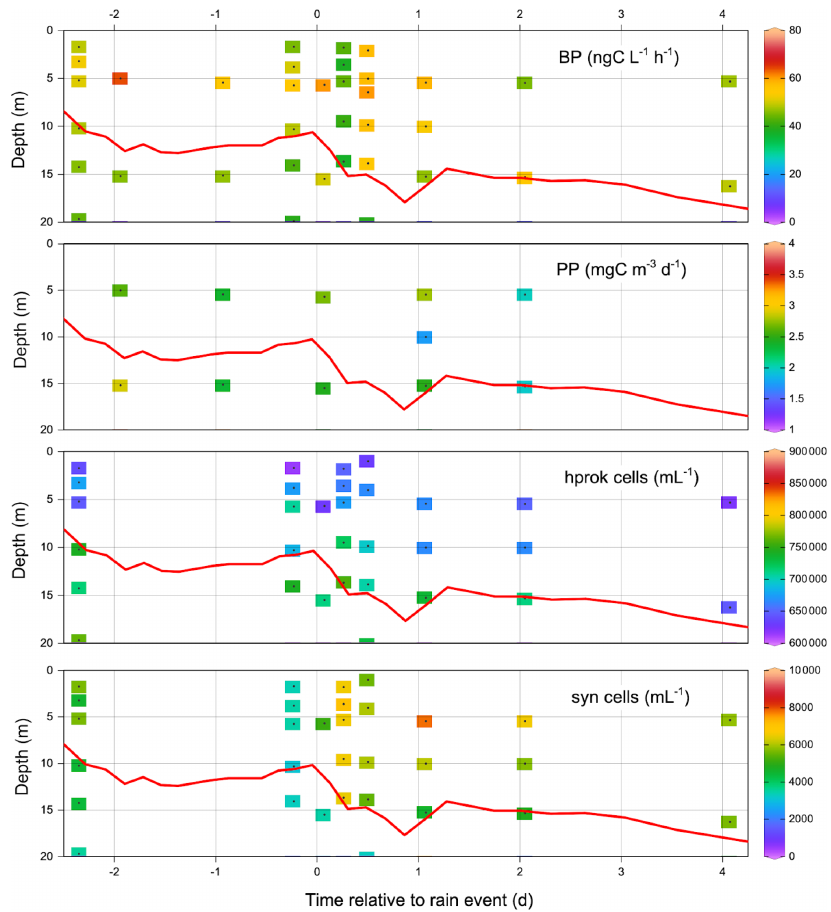
Figure 5. Evolution within the ML of heterotrophic prokaryotic production (BP), primary production (PP), heterotrophic prokaryotes (hprok) and Synechococcus (syn) abundances at FAST. The mixed layer depth is indicated by a red